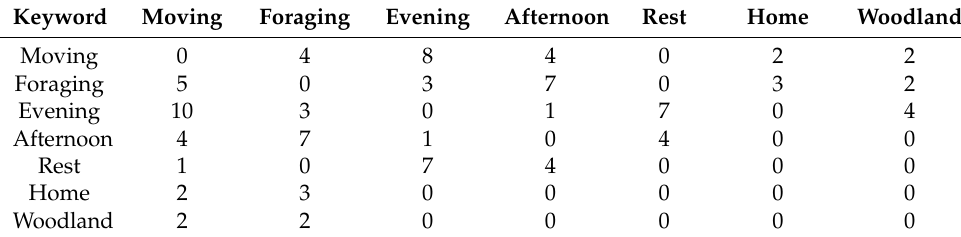
Table 4. Examples of co-occurrence matrix of keywords.